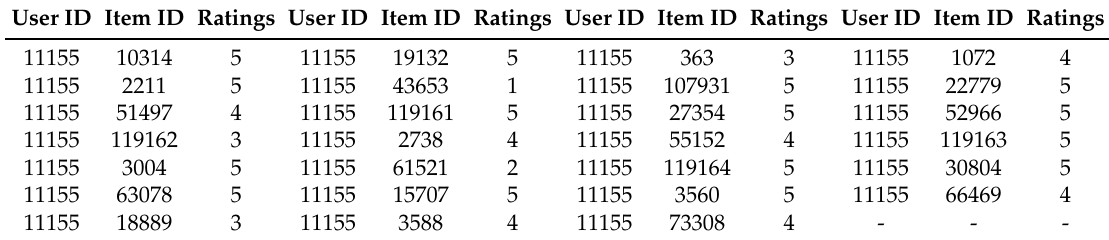
Table 1. Known ratings of a target user u 11155